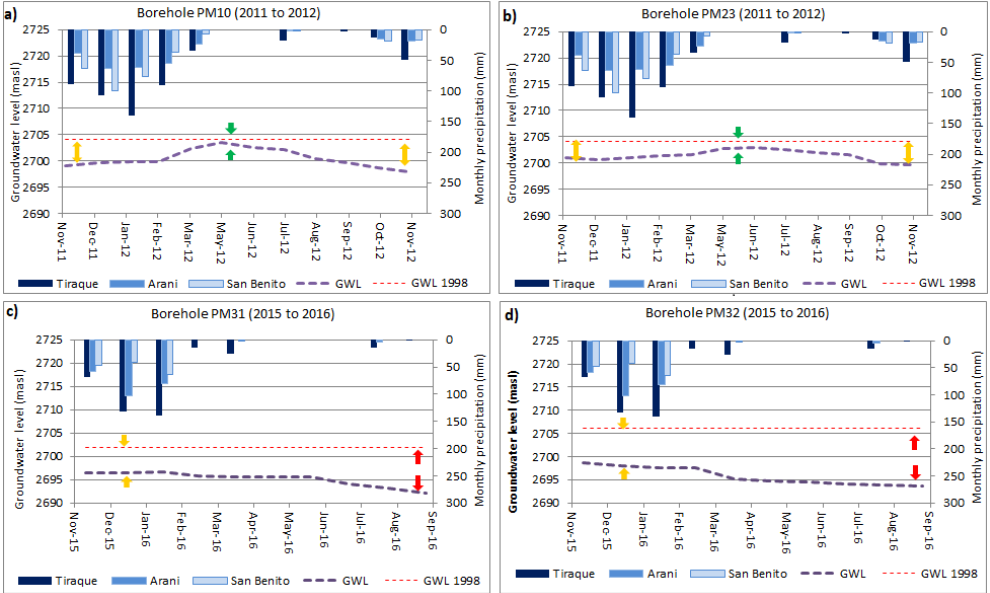
Figure 7. ( a , b ) Selected monitoring wells during the period 2011 to 2012; ( c , d ) Monitoring wells during the period 2015 to 2016. For location of the monitoring wells, refer to Figure 6b. Each figure shows on top the monthly precipitation variation, while the dashed lines represents the recorded groundwater level (GWL) variation during each period and during the year 1998.